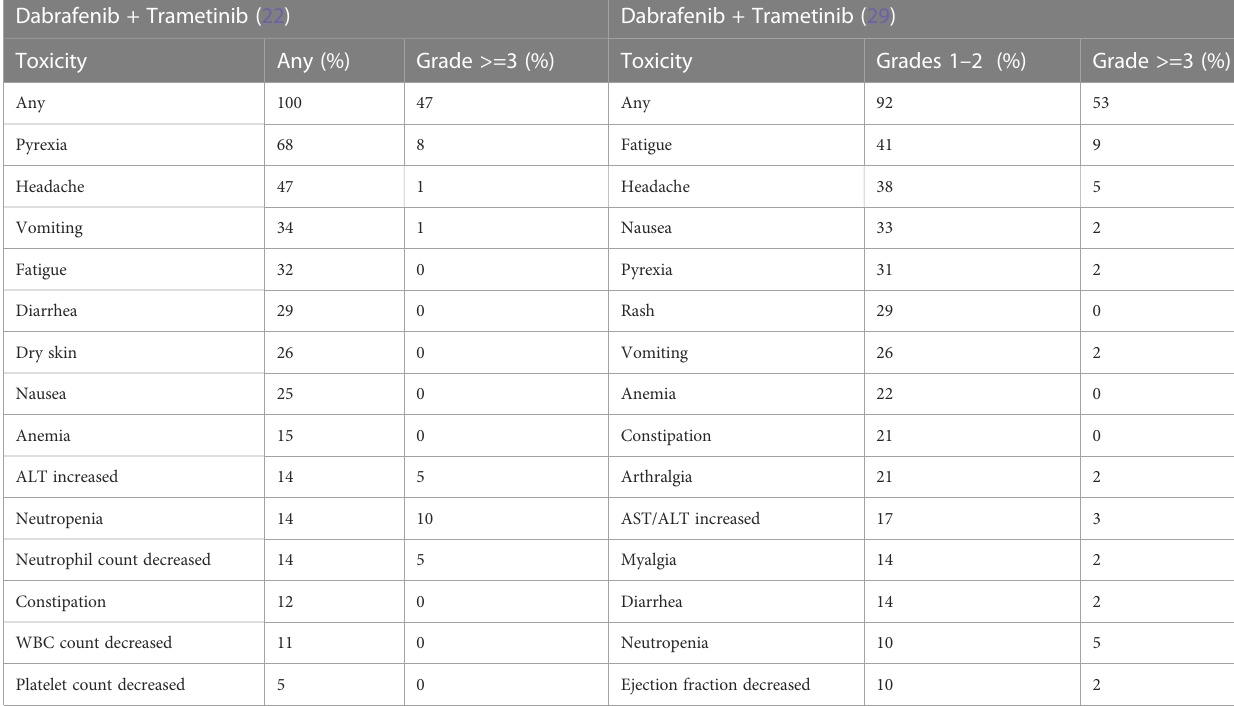
TABLE 3 Adverse events of combination therapy reported in glioma